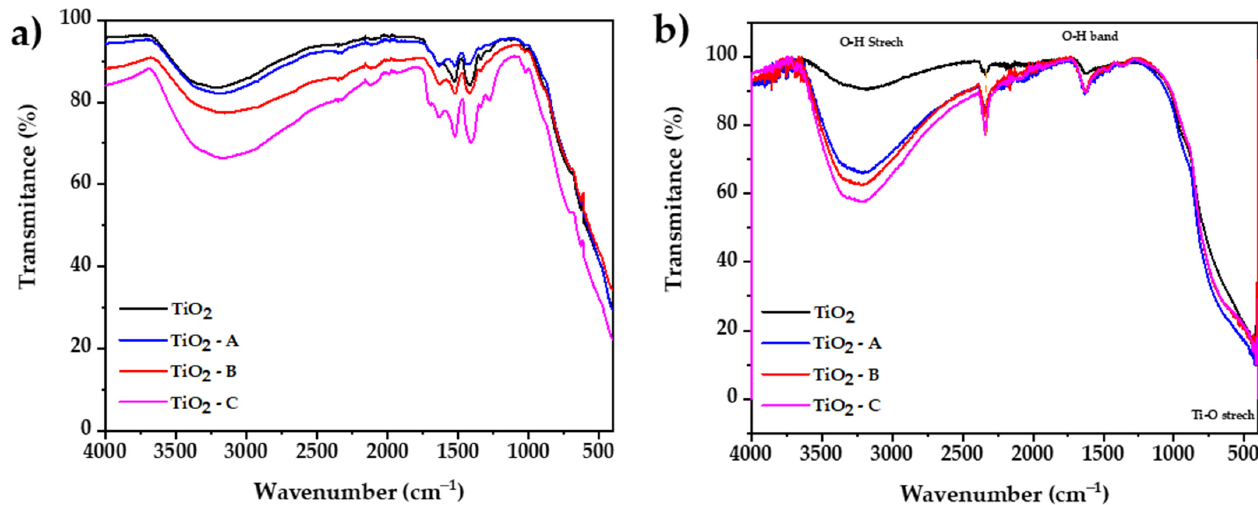
Figure 5. FTIR spectrums of ( a ) prepared dried gel and ( b ) calcined samples.